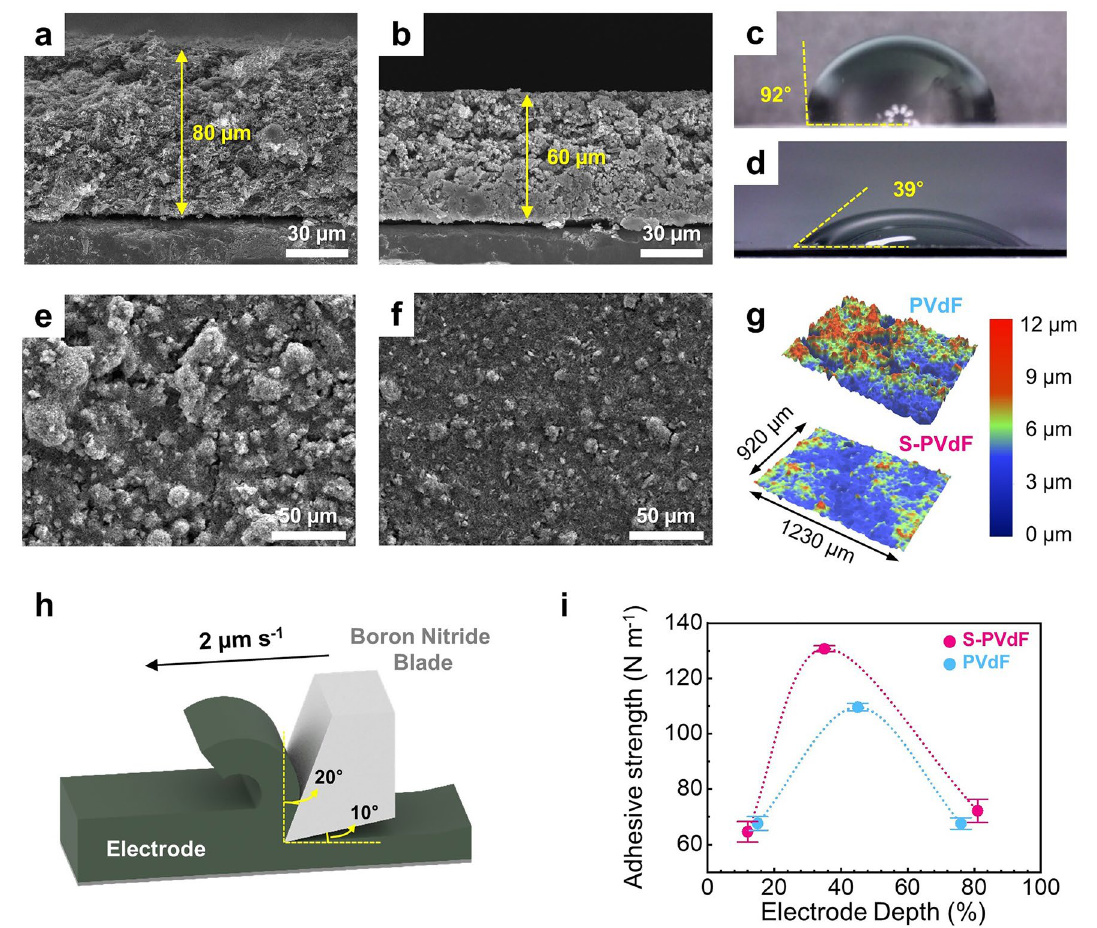
Fig. 2 Cross-sectional SEM images of cathodes with S-PVdF binders a before and b after the calendering process. Contact angles of cathodes with c PVdF and d S-PVdF binders with 2 M ZnSO 4 electrolyte. Top-view SEM images of cathodes with e PVdF and f S-PVdF binders. g 3D surface roughness maps of cathodes with different binders. h The schematic illustration of the SAICAS experiment. i The adhesive strength of the cathodes with S-PVdF and PVdF binders at various electrode